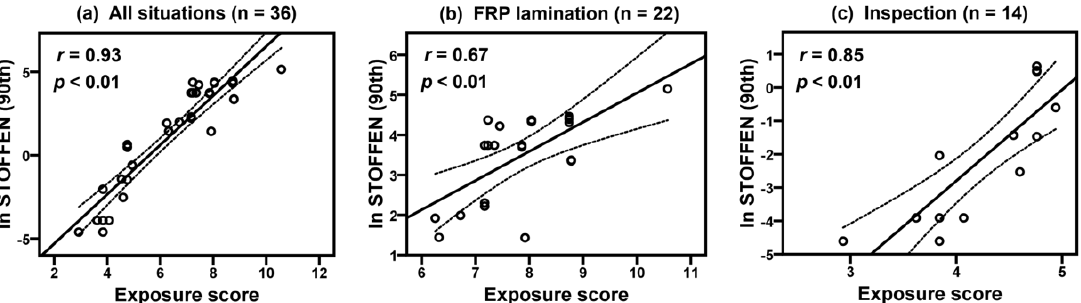
Figure 3. Scatterplots of the log-transformed model estimations (90th) of Stoffenmanager and exposure scores calculated using a new model for styrene collected on the FRP lamination and inspection tasks on situation level. The dashed lines indicate corresponding 95% CIs.